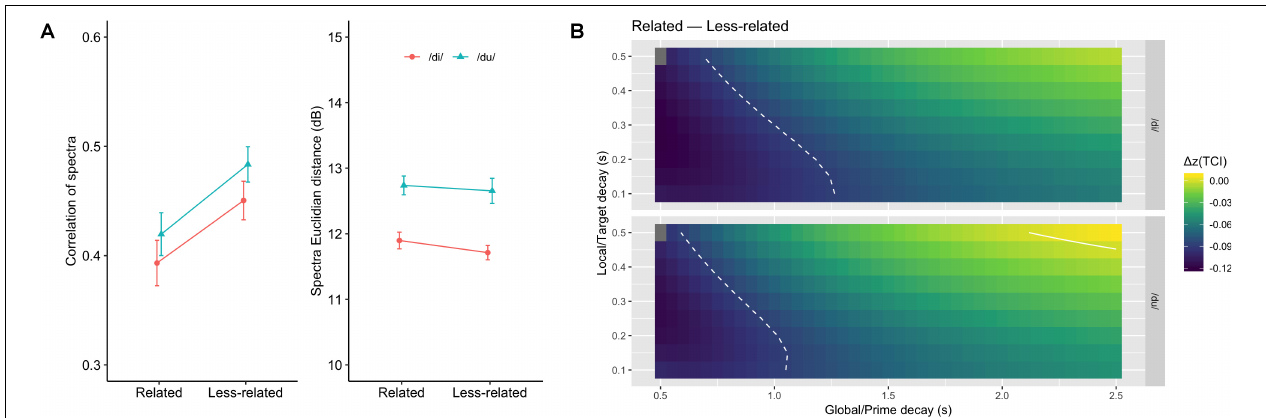
FIGURE 2 | (A) Average spectral correlation (left) and Euclidian distance (right) for the related and less-related condition, and for the two target syllables. Higher correlations, and smaller Euclidian distances, are compatible with more sensory priming. (B) Difference in Fisher transformed tonal contextuality index between related and less-related conditions, as a function of syllable, and global and local decays. The solid line represents the value 0.0 where the two types of context have the same TCI. The dashed lines represent the critical limit beyond which differences can be considered significant.